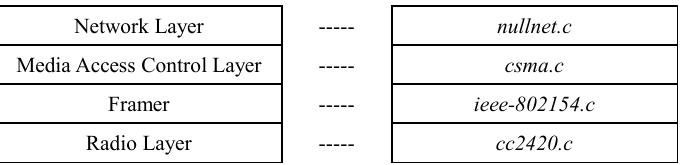
Figure 2. Contiki-NG network protocol stack.